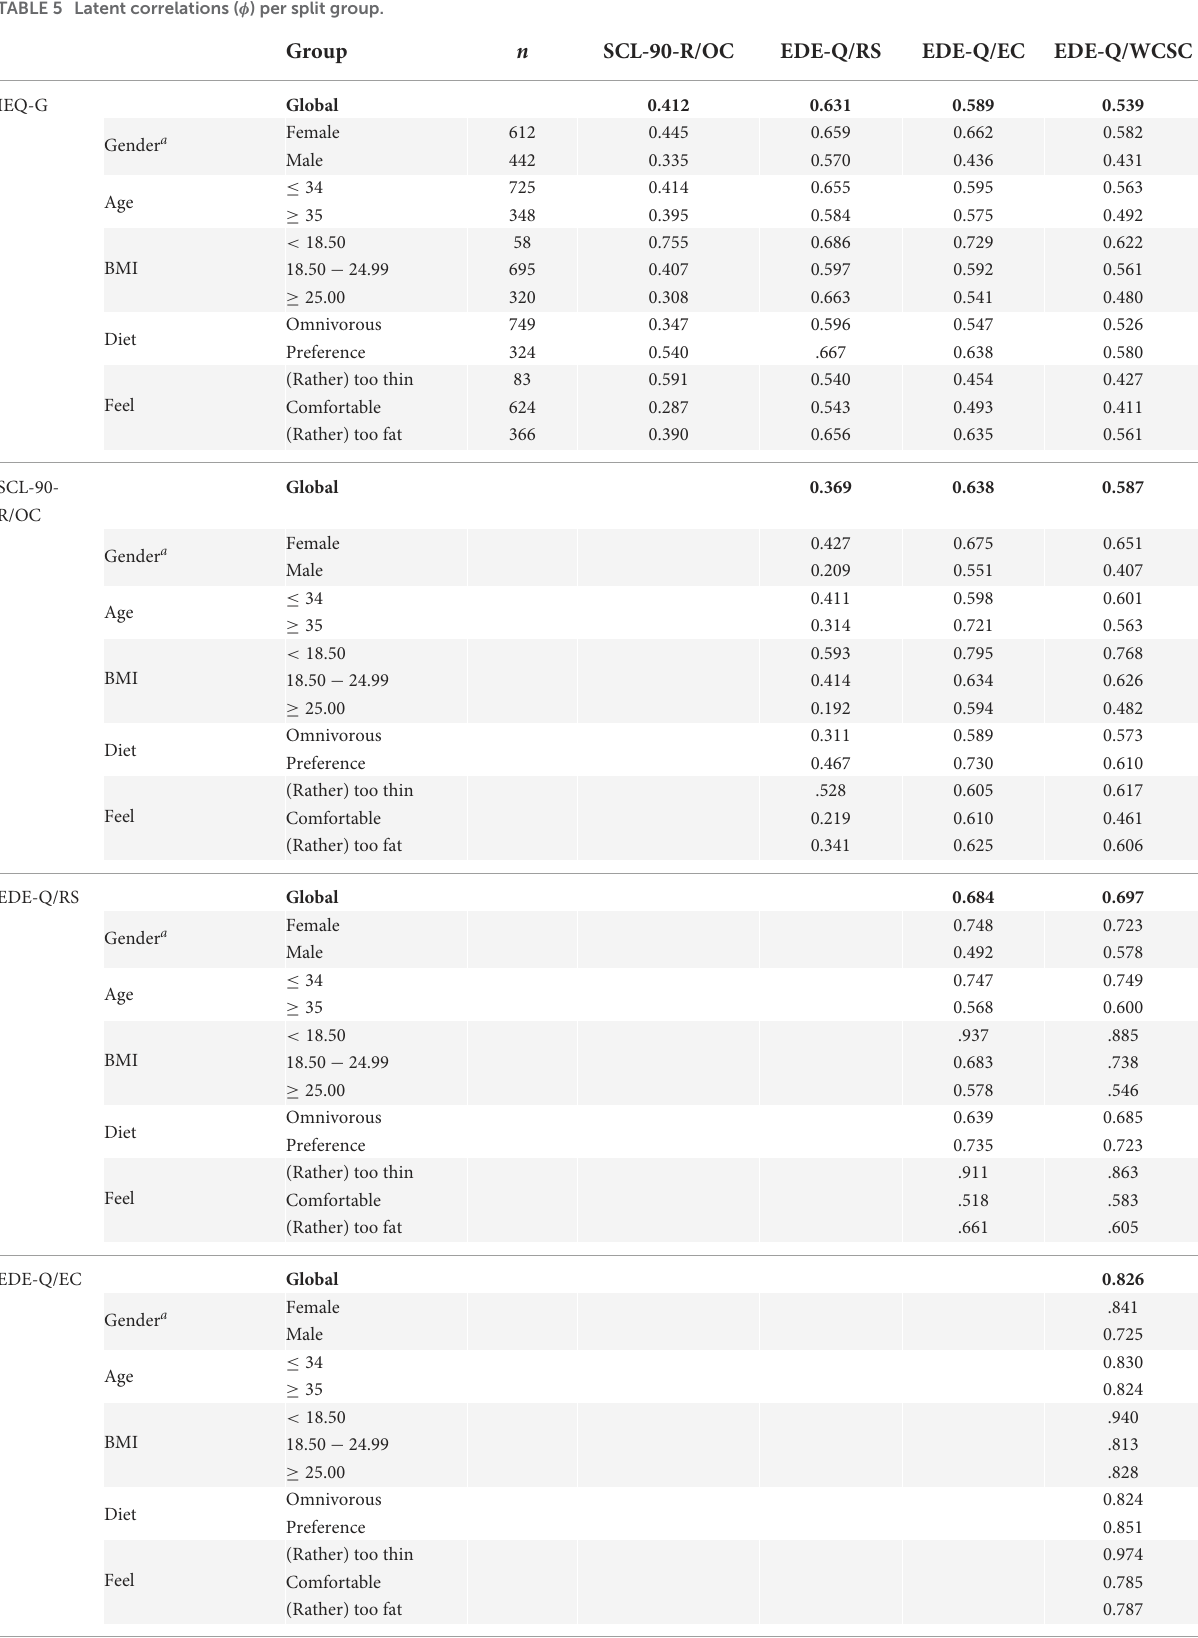
TABLE 5 Latent correlations ( φ ) per split